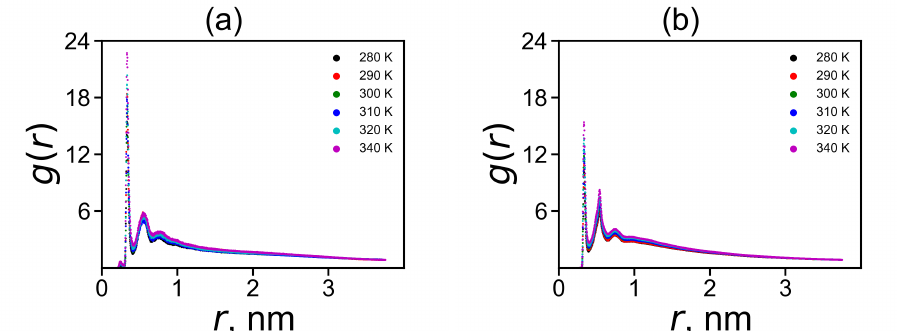
Figure 7. The radial distribution function of ion pairs between ions and charged terminal groups in ( a ) Lys-2His and ( b ) Lys-2Hisp at different temperatures.